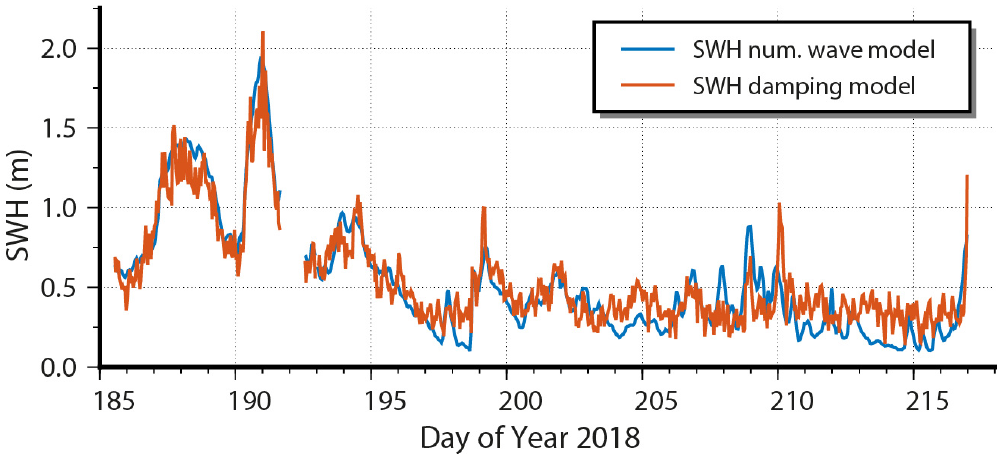
Figure 6. Time series of the interpolated wave model SWH values (blue) and of the SWH calculated with the hourly averaged damping coefficients (red).